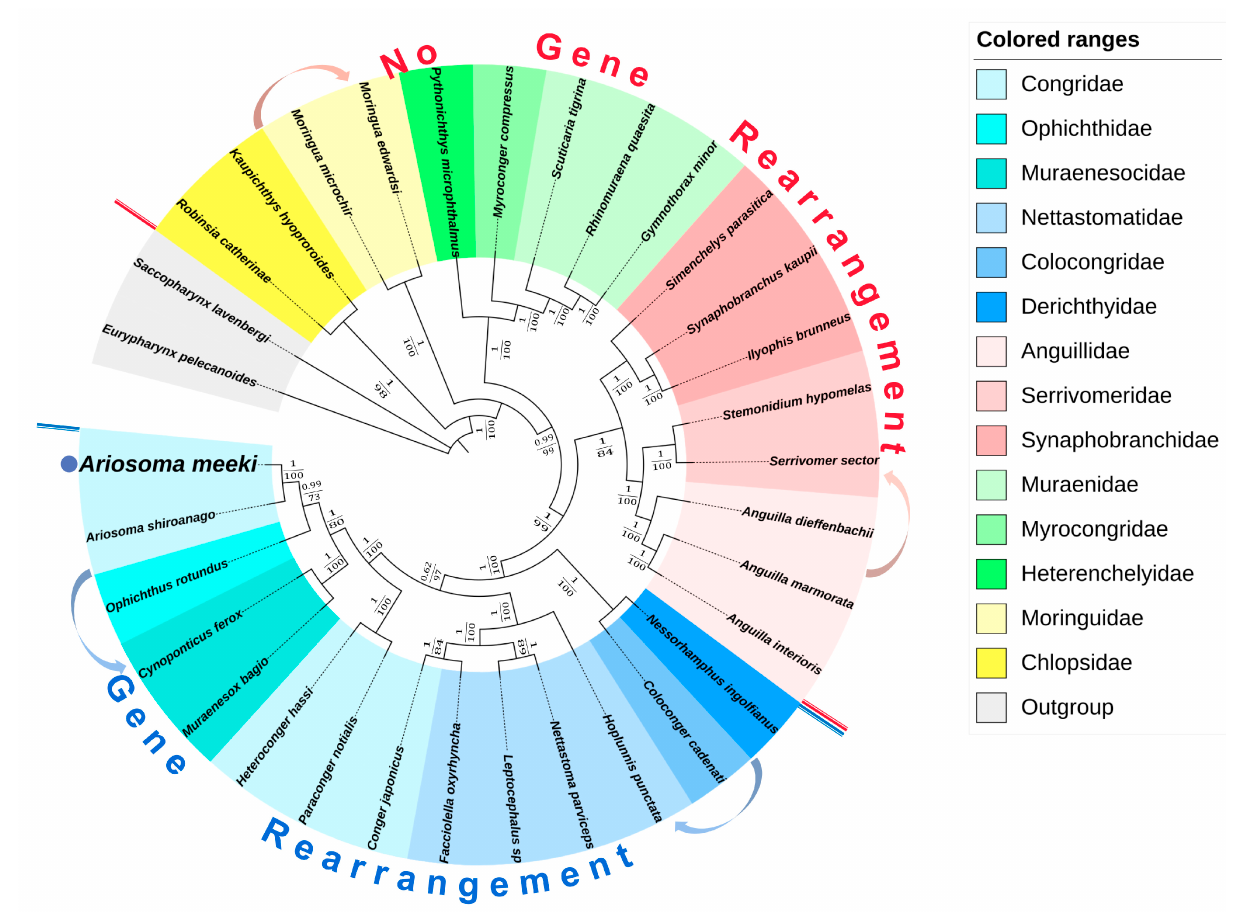
Figure 8. Phylogenetic tree of the Anguilliformes inferred from the nucleotide sequences of 12 PCGs (except for ND6 ) using the Bayesian inference (BI) and maximum likelihood (ML) methods. The numbers on the branches indicate posterior probability (BI) and bootstrap (ML).